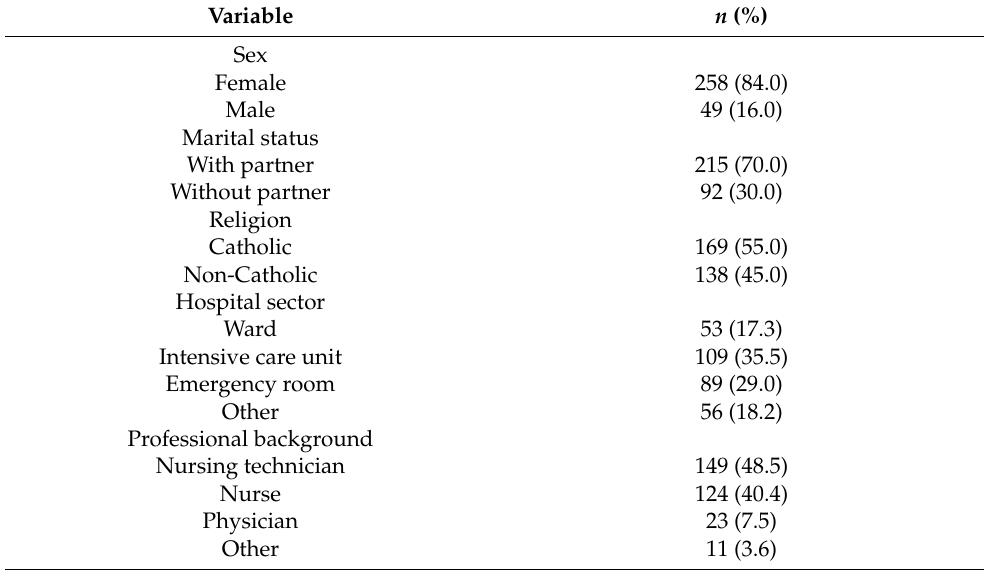
Table 1. Sociodemographic characteristics of participants ( n =